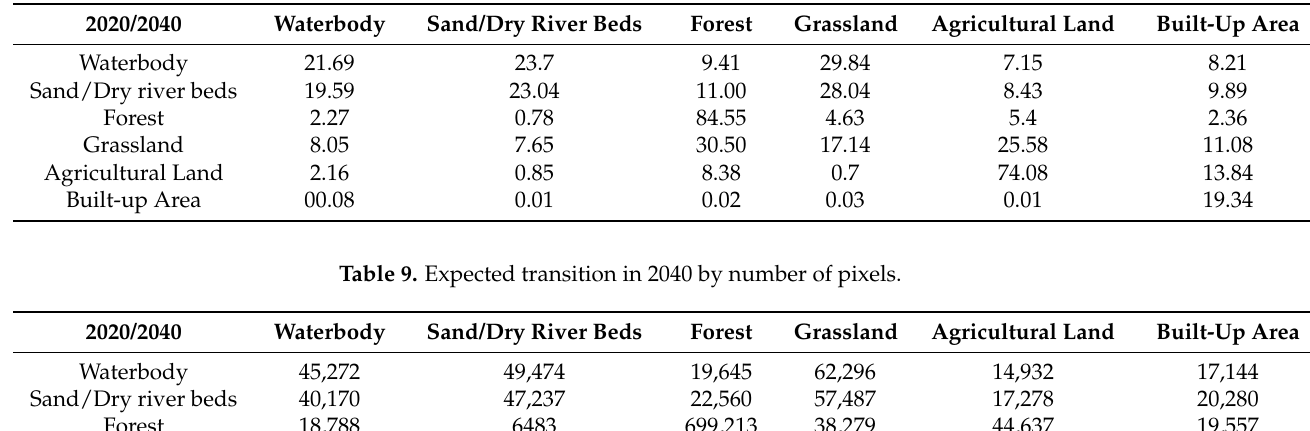
Table 8. Probability of LULC changes in 2040 by percentage.